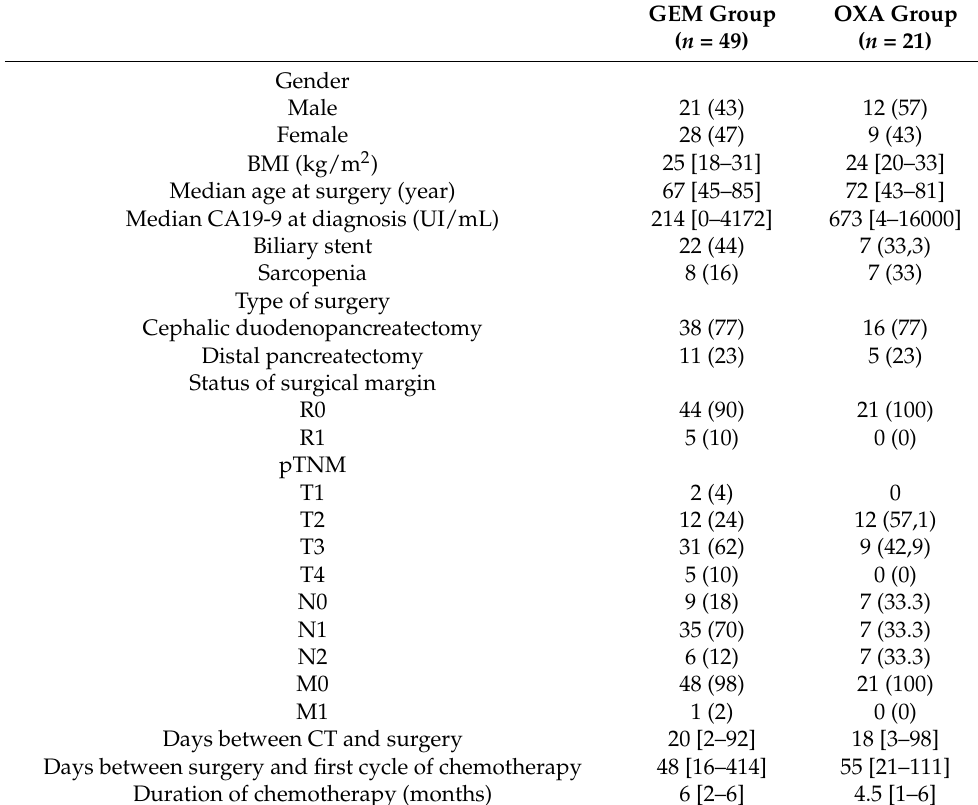
Table 1. Characteristics of the study population according to the type of adjuvant